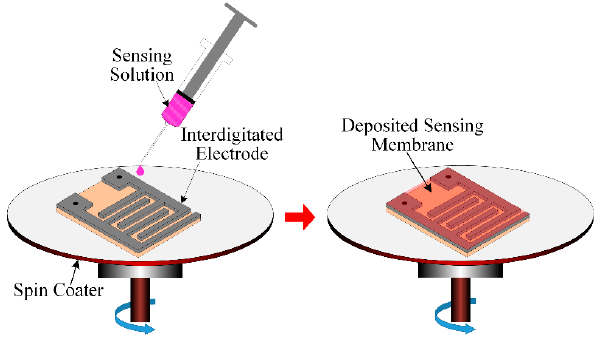
Figure 5. Deposition process of the sensing/dielectric solution into the IDE with a spin coater, to obtain the IDC.